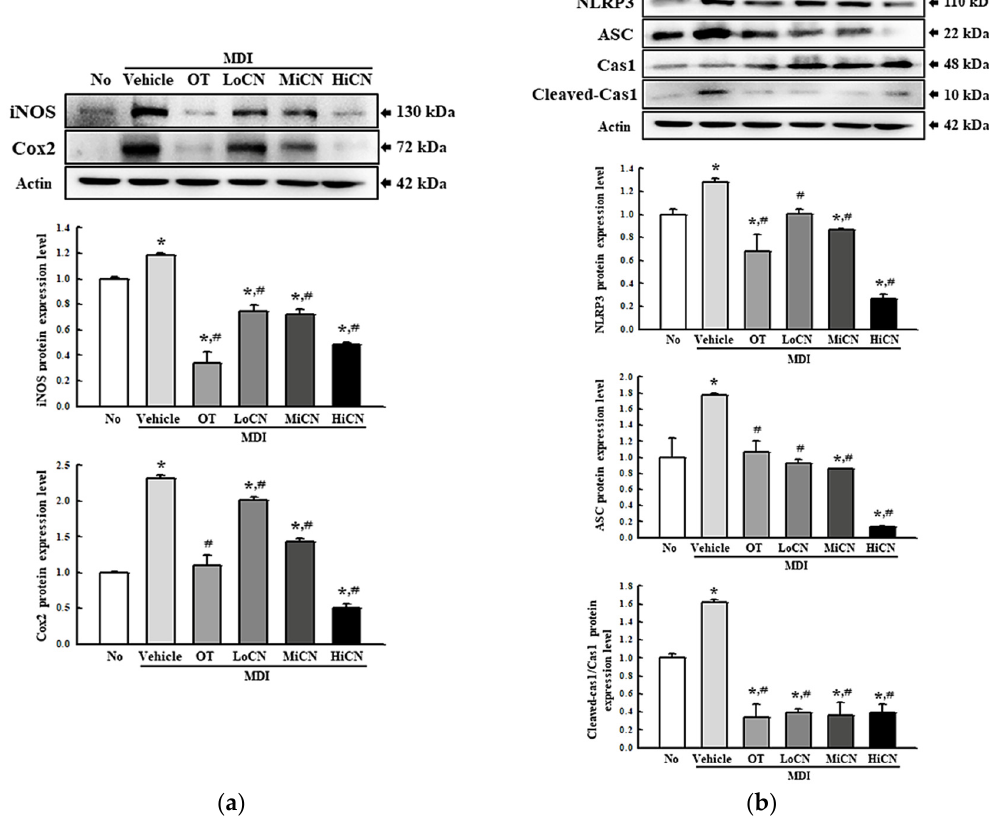
Figure 4. Expression level analyses for inflammatory markers. ( a ) Expression of COX-2 and iNOS proteins. After collecting the total proteins from MDI-stimulated 3T3-L1 adipocytes treated with α -cubebenol, the expression level of iNOS, COX-2, and β -actin were detected using the specific primary antibodies, followed by horseradish peroxidase (HRP)-conjugated goat anti-rabbit IgG. The intensity of each band was measured by an imaging densitometer, and the relative levels of each protein were calculated relative to the intensity of the actin bands. ( b ) Expression of inflammasome proteins. After collecting total proteins from MDI-stimulated 3T3-L1 adipocytes treated with α -cubebenol, the levels of NLRP3, ASC, Cas-1, Cleaved Cas-1, and β -actin expression were measured by Western blot analysis using the specific antibodies and HRP-conjugated anti-rabbit IgG antibody. Two to three dishes per group were used to prepare cell homogenates, and Western blot analysis was assayed in duplicate for each sample. The data represent the means ± SD of three replicates. * indicates p < 0.05 compared to the No treated group. # indicates p < 0.05 compared to the MDI + Vehicle treated group. OT, orlistat; MDI, adipogenic cocktail consisting of 3-isobutyl-1-methylxanthine, dexamethasone, and insulin; LoCN, low concentration (7.5 μ g/mL) of α -cubebenol; MiCN, middle concentration (15 μ g/mL) of α -cubebenol; HiCN, high concentration (30 μ g/mL) of α -cubebenol.